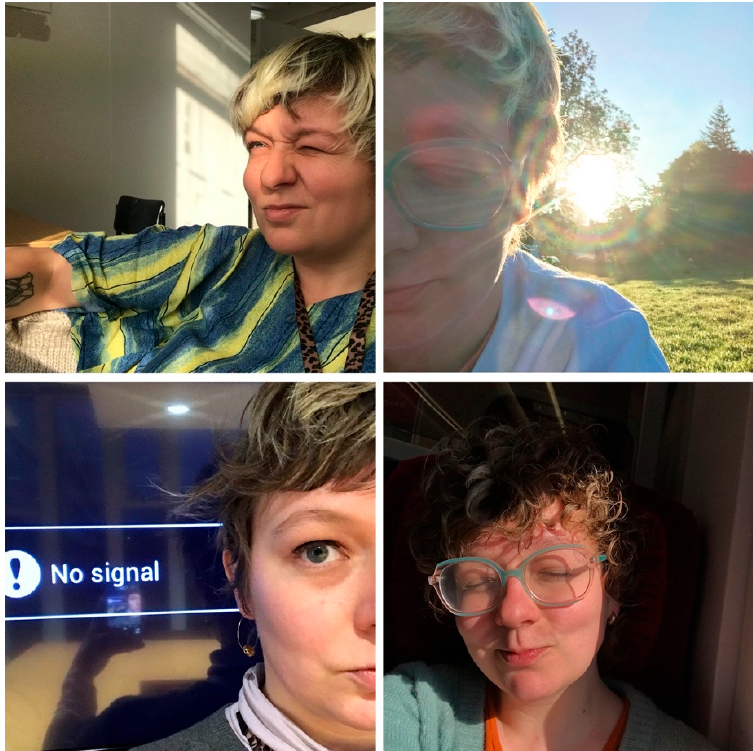
Figure 5. Tracking the passage of time: a prompt from the fledgling community radio station results in a new ‘algorithm-friendly’ selfie to accompany each show. Image icons for episodes 4, 6, 8 and 11 of Holding My Nerve Grace Denton and Slacks Radio, 2021–2022.